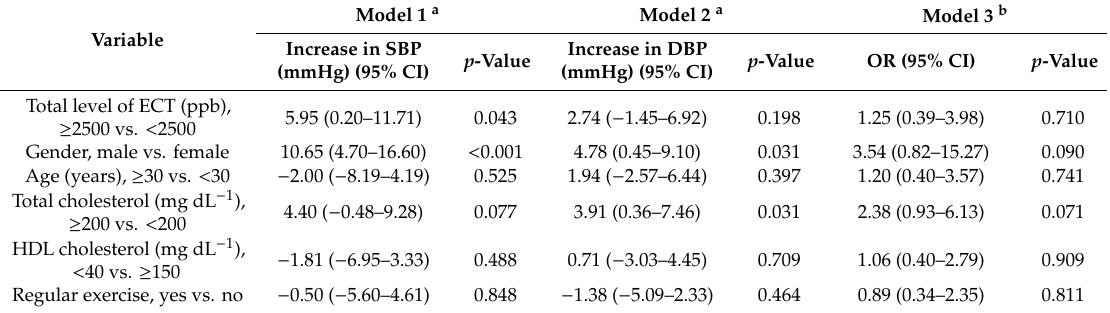
Table 6. Associations between VOCs exposure, blood pressure and the risk of hypertension.